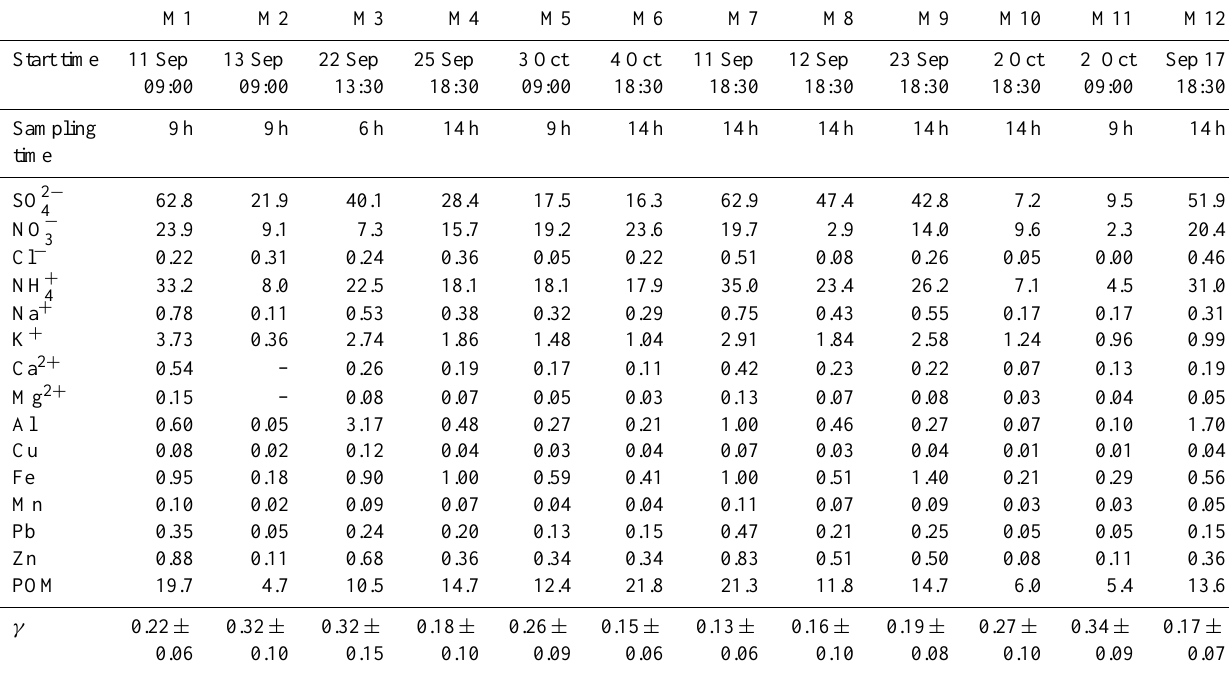
Table 2. Concentrations (µgm − 3 ) of the measured components in sampled particles (PM 2 . 5) at Mt. Mang, together with measured uptake coefficients ( γ ) in this